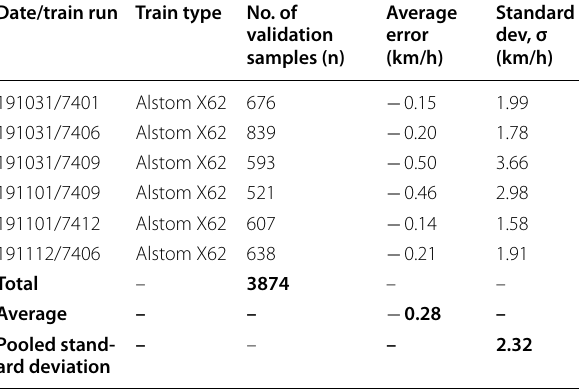
Table 4 Alternative 2: speed validation based on position